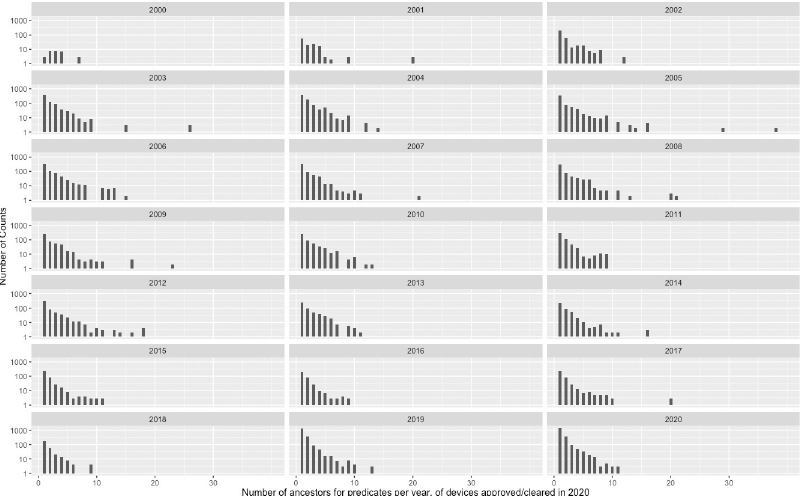
Fig 1. Histogram showing the distribution of the number of predicate “parent” devices from 2000 to 2020 for 462 medical devices cleared through the 510(k) regulatory pathway in 2020. The y axis is a log scale. Note that an outlier of 62 predicates (histogram count of 1) in 2015 has been not indicated, in order to enhance readability of the histograms shown.